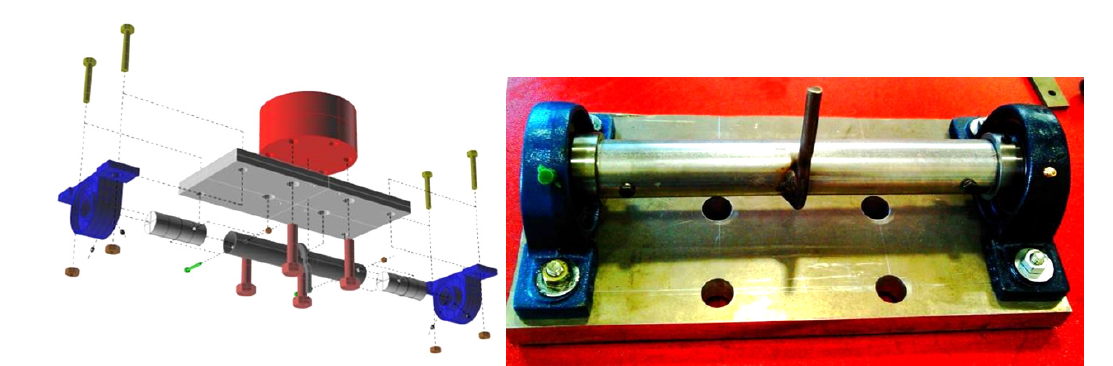
Figura 5: Modellazione piastra e supporto e sistema di vincolo del secondo tipo.